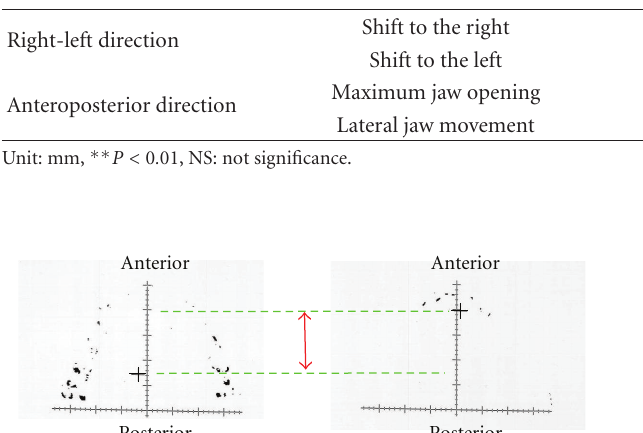
Figure 7: Visual analogue scale for tooth